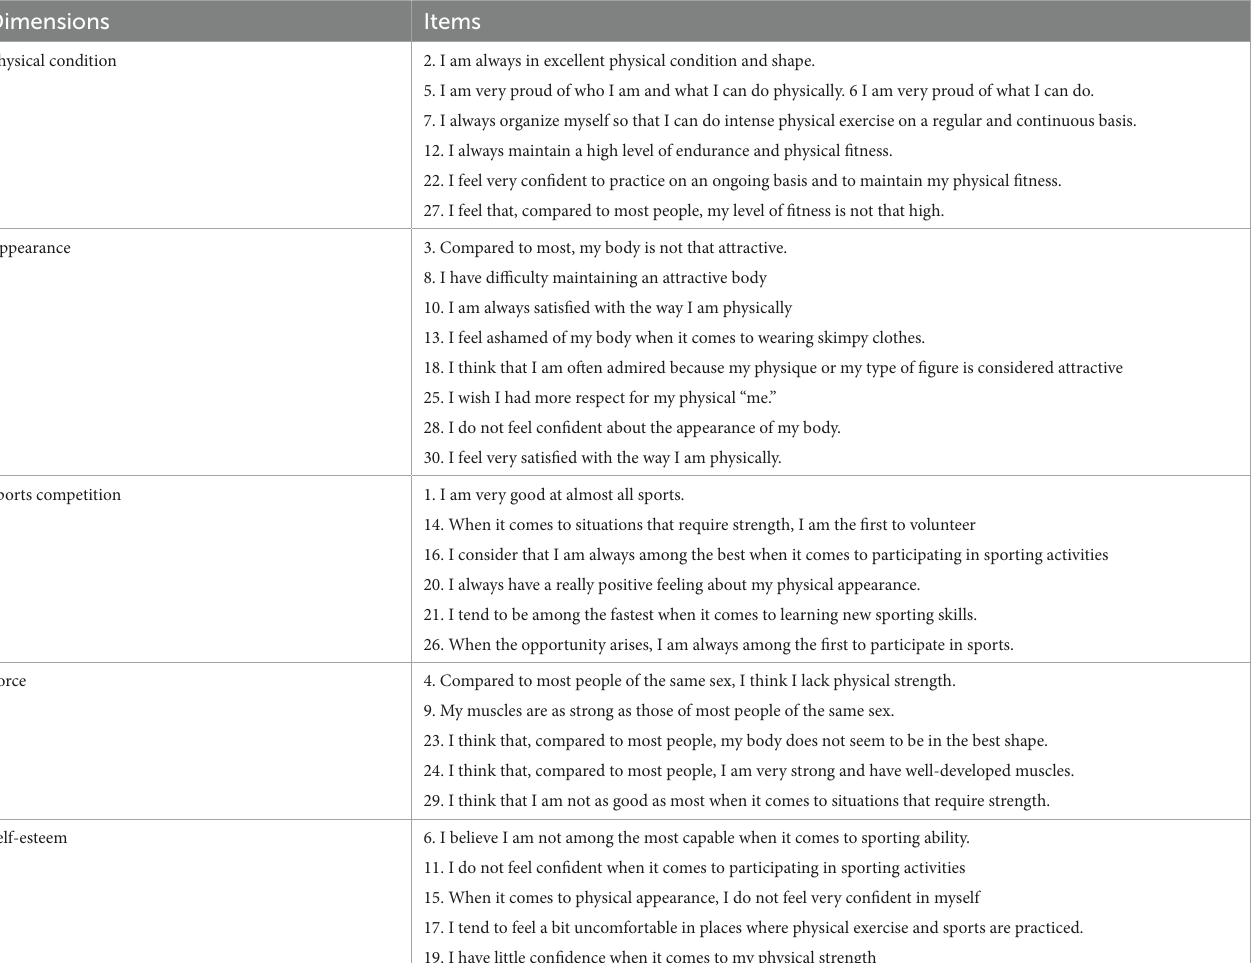
TABLE 1 Operationalization of the variable studied. Dimensions